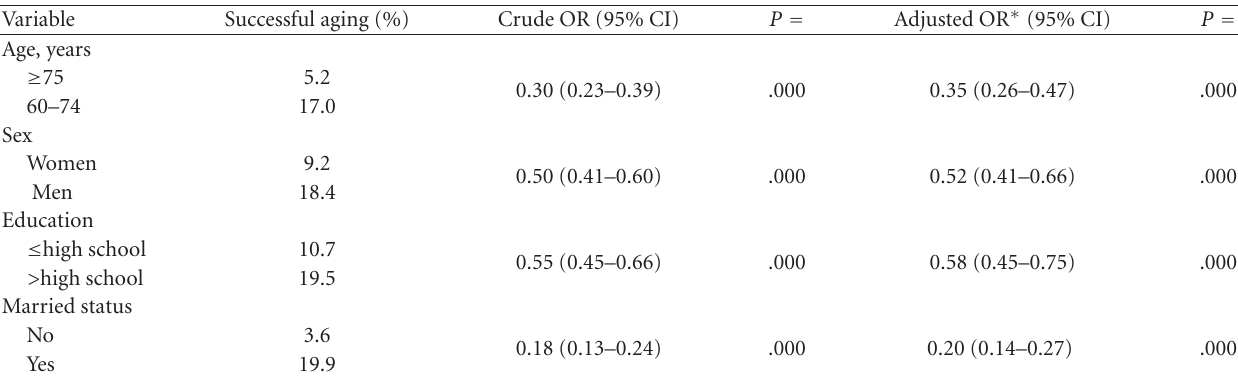
Table 4: Crude and adjusted odds ratio for successful